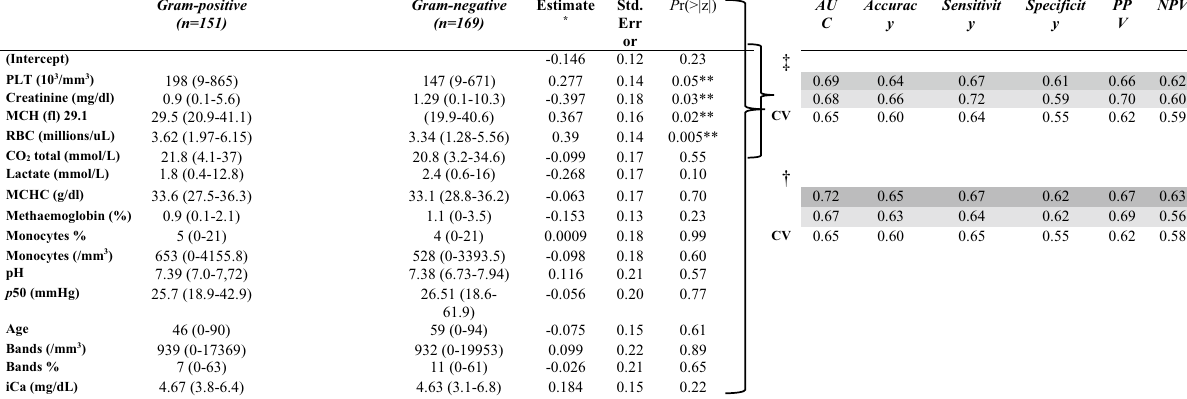
Table 4. Estimated coefficients for each selected variable. Adjustment, Validation and Prediction, considering the previously filtered variables (16) for performance in the prediction of Gram-negative bacteremia. Data given as mean (minimum and maximum values). n number of samples, iCa ionized calcium, CO 2 carbon dioxide, MCH mean corpuscular haemoglobin, MCHC mean corpuscular haemoglobin, pH hydrogen potential, PLT platelet count, RBC red blood cell count. † Model Complete. Estimate*: logistic regression coefficients estimates. **Only the variables are statistically significant at a 5% significance level ( ‡ Model Reduced). AUC = area under curve PPV = Positive Predictive Value NPV = Negative Predictive Value CV = coefficient of variation. Accuracy, Sensitivity, Specificity, PPV and NPV estimates were obtained considering a cutoff value equal to 0.50. Dark grey: Validation (n = 320) . Light grey: Prediction using the 2019 database (n = 69) . The coefficients estimated (Std. Error) for Creatinine, MCH, PLT and RBC in the Reduced Model are—0.53 (0.14), 0.34 (0.13), 0.35 (0.13) and 0.36 (0.13) respectively.